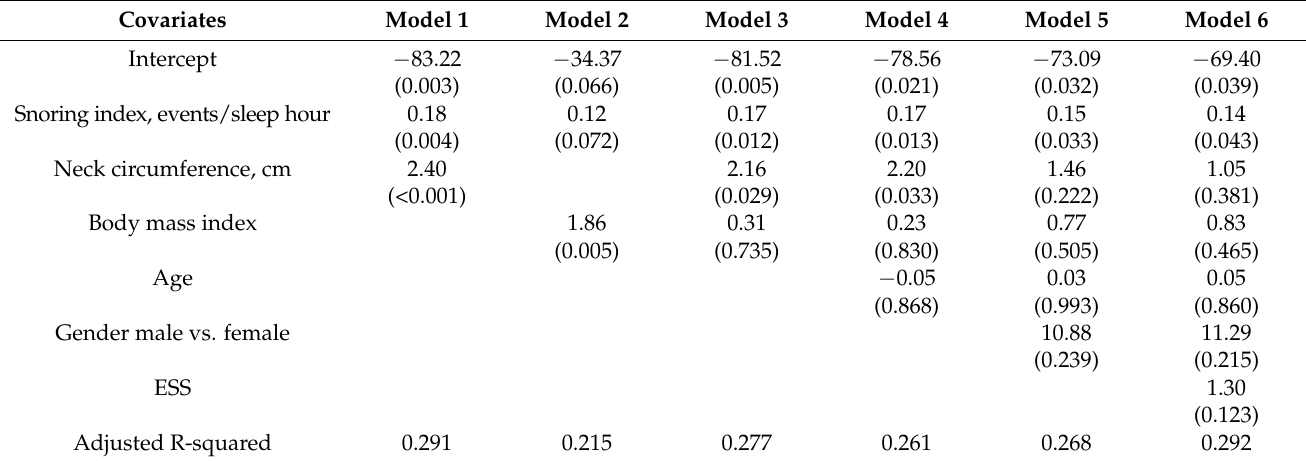
Table 4. Multiple linear regression for the apnea–hypopnea